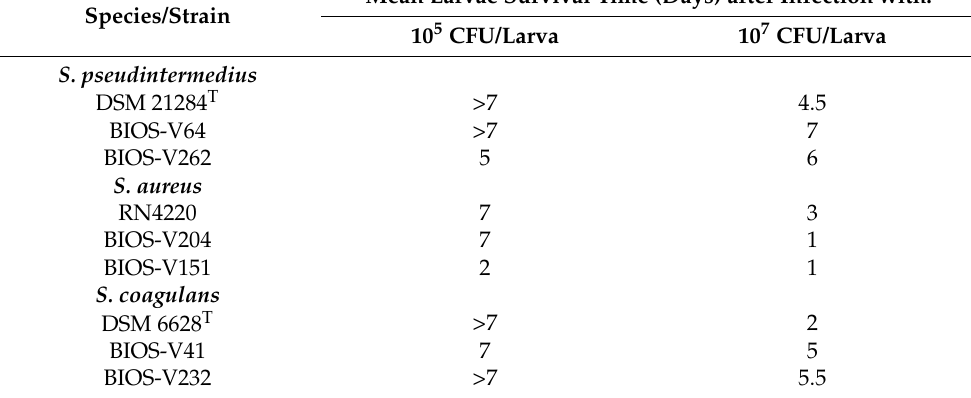
Table 2. Mean survival time of G. mellonella larvae infected with representative biofilm-producing CoPS